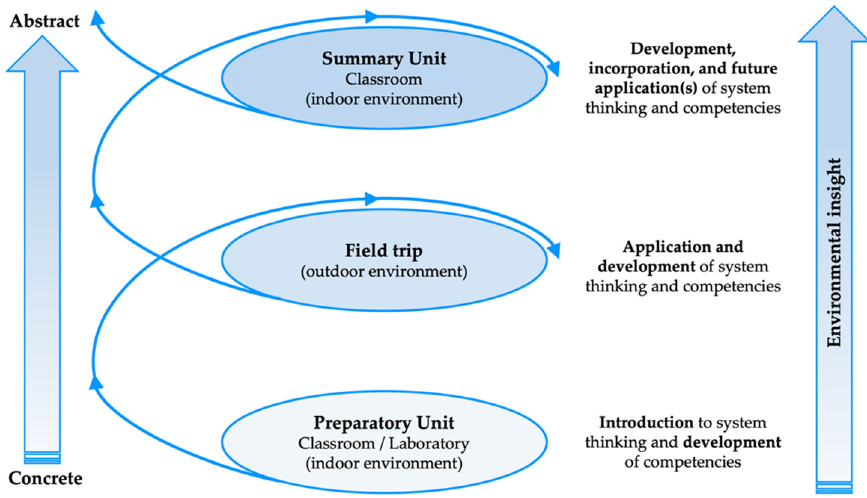
Figure 1. Orion’s field trip model with the integration of system thinking and environmental insight development (adapted from Orion [57] (p. 329)).